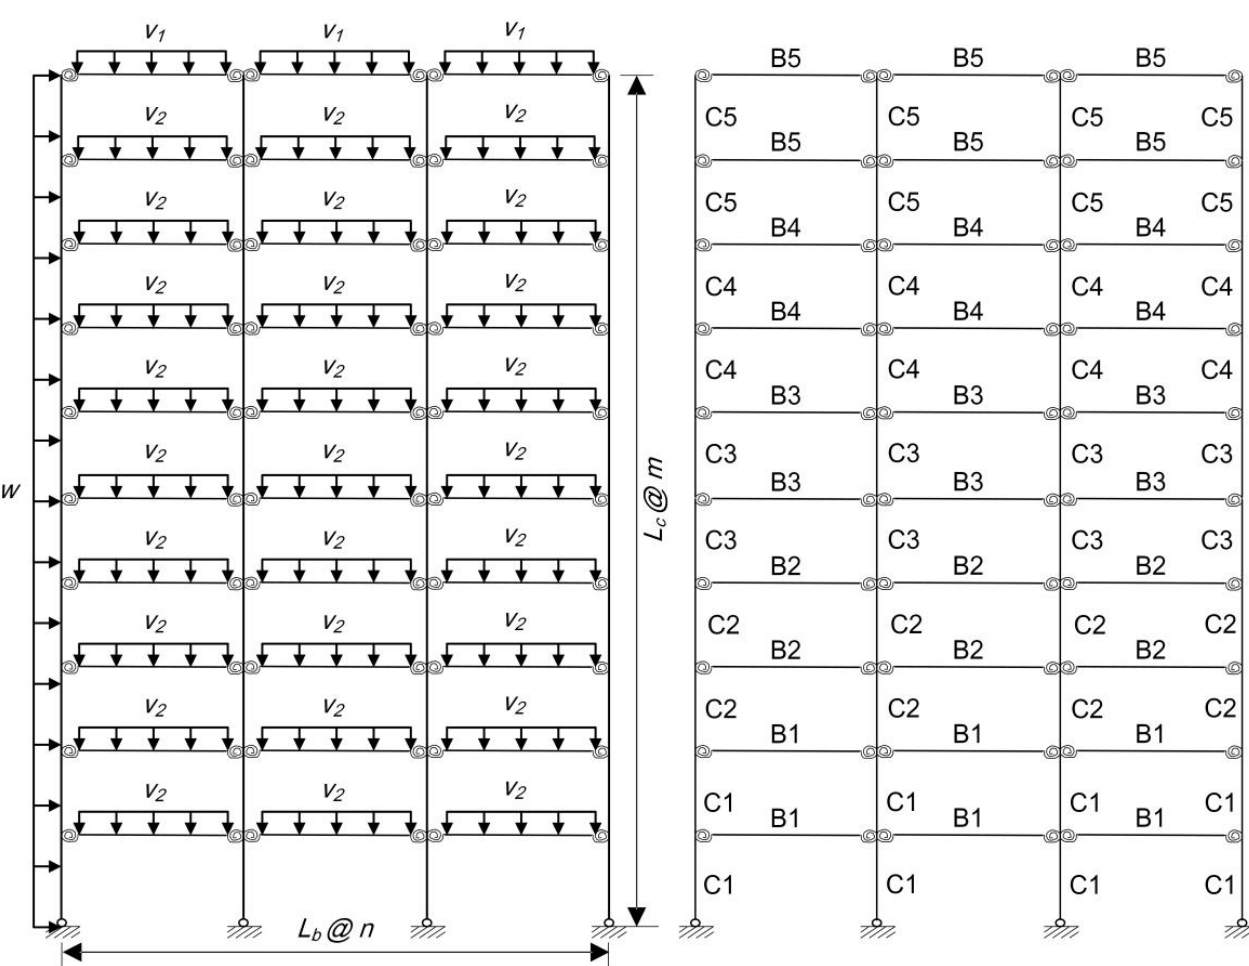
Figure 9. The layout of multi-story and multi-bay frame.